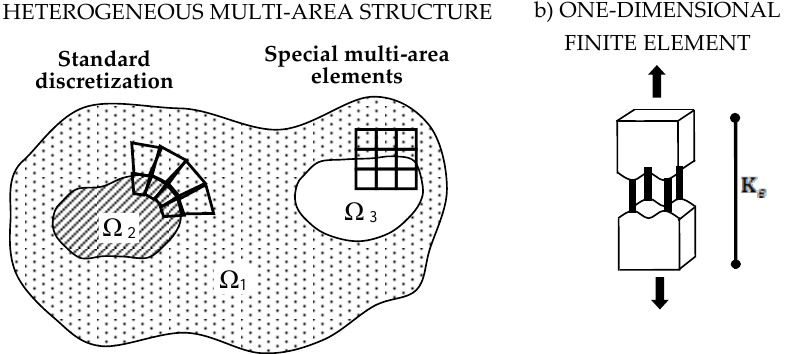
Figure 1. Example of multi-area elements for 2-D and 1-D case. ( a ) Heterogeneous multi-area structure; ( b ) One-dimensional finite element.